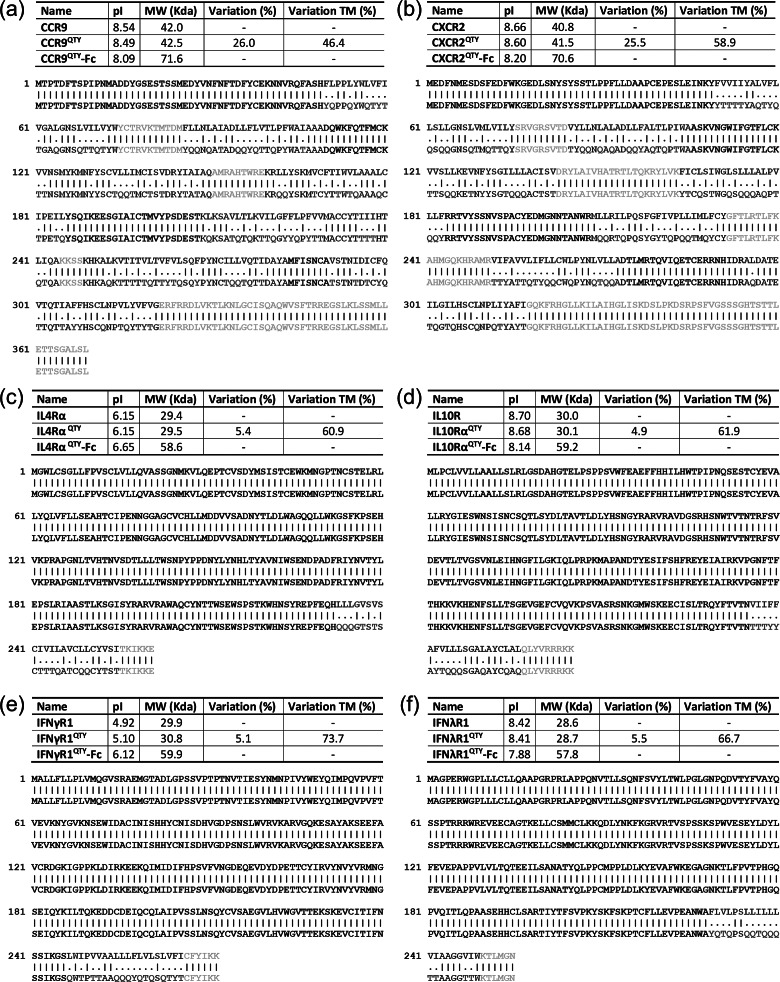
Protein sequence alignment between natural (Top) and QTY redesigned cytokine receptors. (a) CCR9 versus CCR9QTY; (b) CXCR2 versus CXCR2QTY; (c) IL4Rα versus IL4RαQTY; (d) IL10Rα versus IL10RαQTY; (e) IFNγR1 versus IFNγR1QTY and (f) IFNλR1 versus IFNλR1QTY. The substitutions of Q, T, and Y are denoted with ‘.’, while ‘|’ indicates no change in residues between the two sequences. The Q, T and Y amino acid substitutions are colored in red. The N-terminus, extracellular loops are black, transmembrane is blue and intracellular components of the receptors are yellow. Characteristics of native, QTY variant–Fc-fusion receptor proteins’ pI, molecular weight, and overall variation rate and that % changes only transmembrane segments are presented.